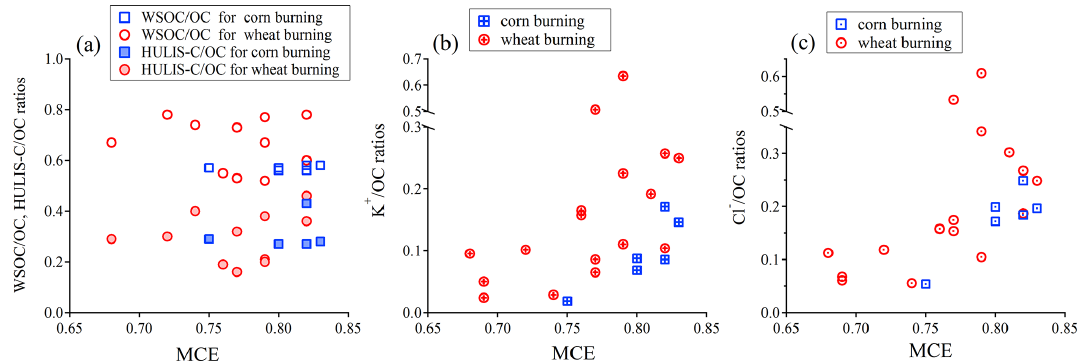
Figure 4. Variations of (a) WSOC / OC and HULIS C / OC ratios, (b) K + / OC and (c) Cl − / OC ratios as a function of modified combustion efficiency (MCE) for corn and wheat burning experiments. Corn and wheat burning emissions are denoted by red and blue colors, respectively.